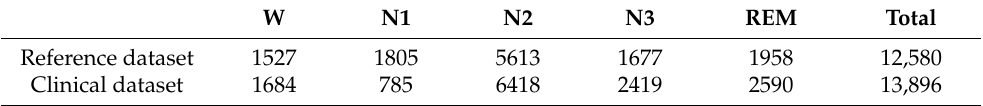
Table 2. Numbers of different sleep stages in Reference dataset and Clinical